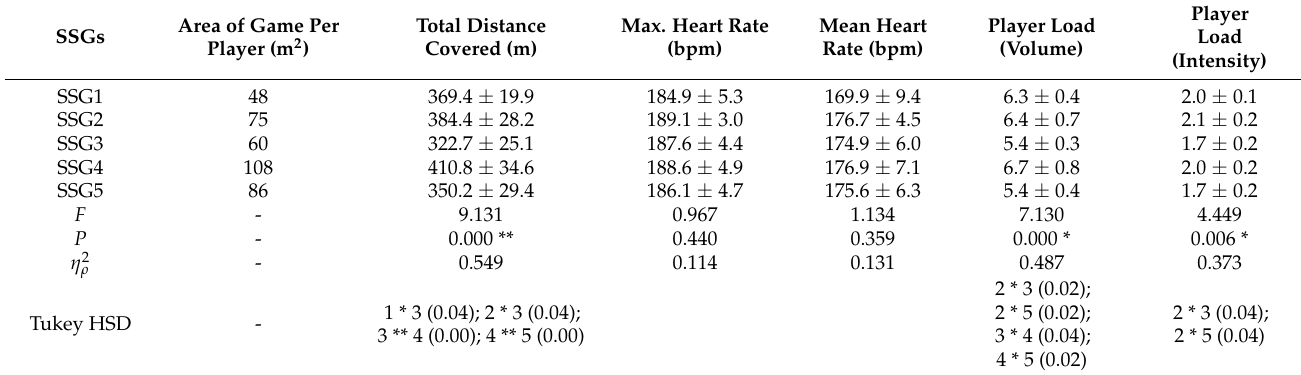
Table 2. Variations between internal and external load variables in different areas of game per player. SSGs